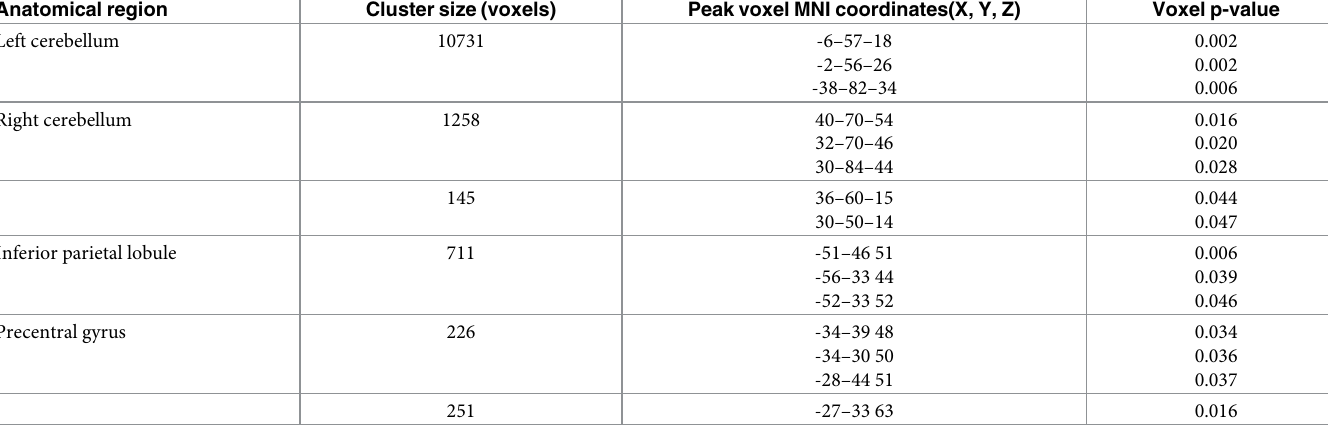
Table 4. Reduced gray matter volume in high ECAT exposure group compared to low ECAT exposure group with covariates. Anatomical